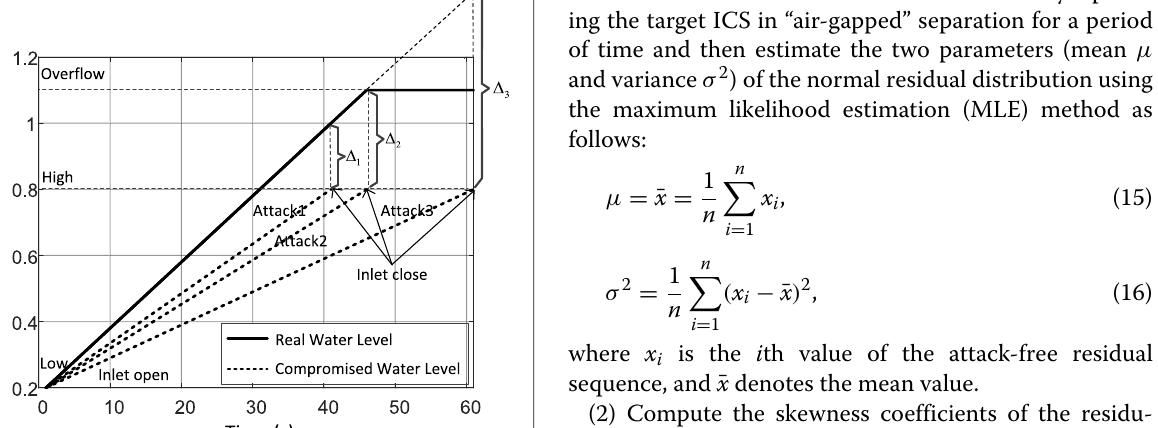
According to the maximum deviations ( (cid:7) ) caused by the three attacks, we can draw a conclusion that only a 2 and a 3 can make the tank overflow, and only a 3 achieves a water spill. a 1 is not a successful attack since it yields a smaller deviation (cid:7) 1 <